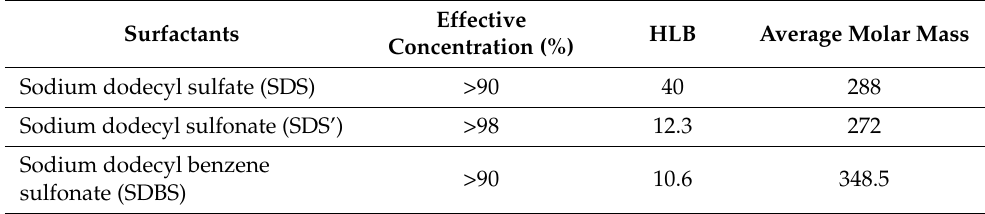
Table 2. Anionic surfactants properties (Adapted with permission from Wang et al. [61]). Copyright 2017, Elsevier